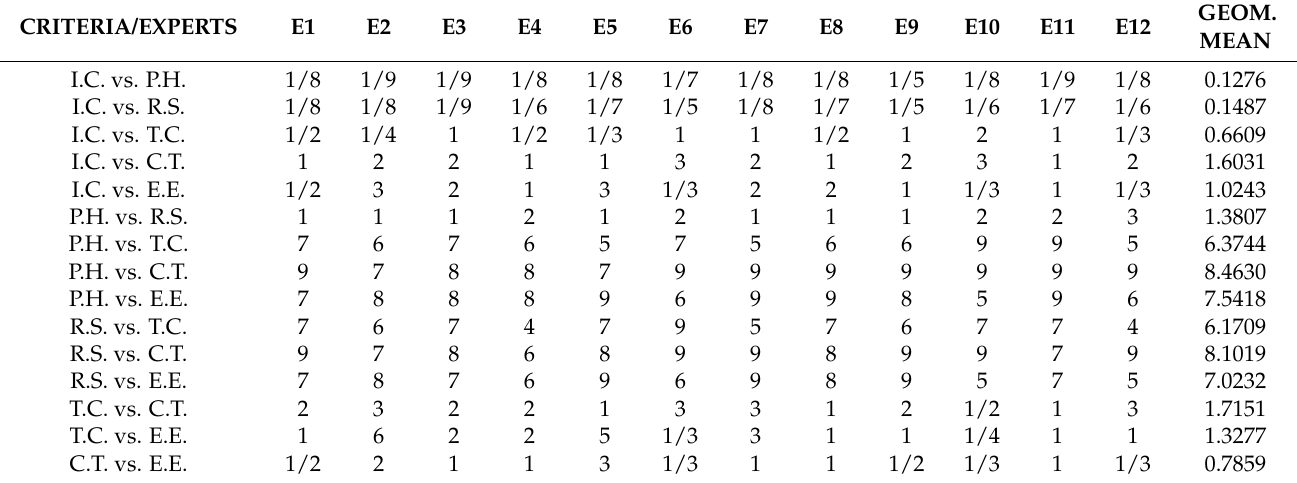
Table 4. Expert judgments and geometric mean for the criteria pair-wise comparisons.